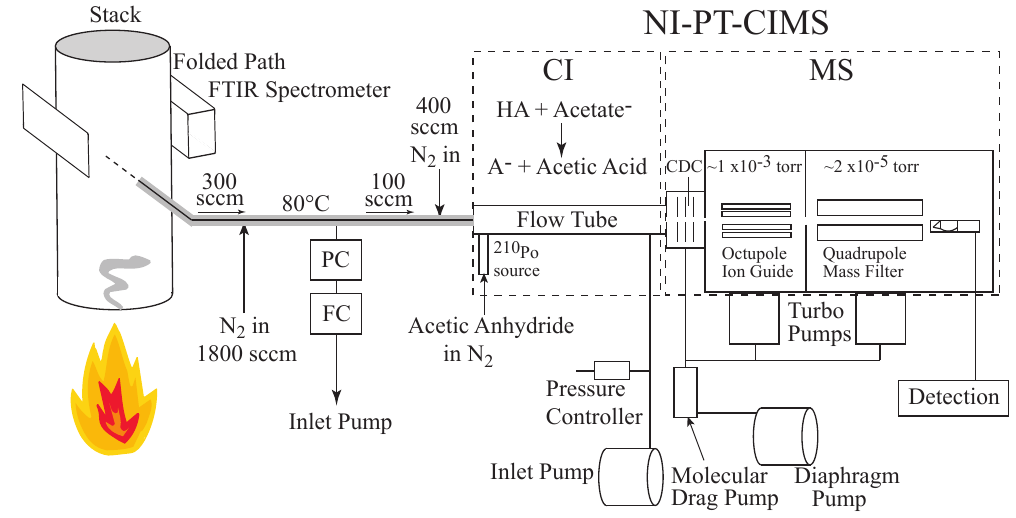
Fig. 1. Diagram (not to scale) of the NI-PT-CIMS and associated inlet system used for sampling the biomass burning experiments. The gray shading on the inlet line denotes the part that was thermo-stated at 80 ◦